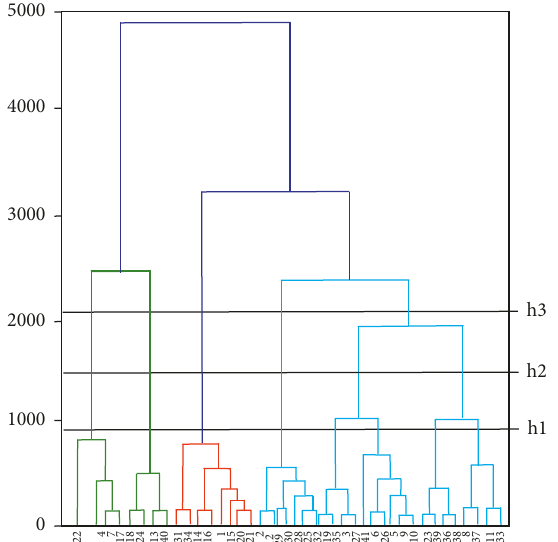
Figure 7: Meal orders clustered into delivery bundles by the ward HAC algorithm.